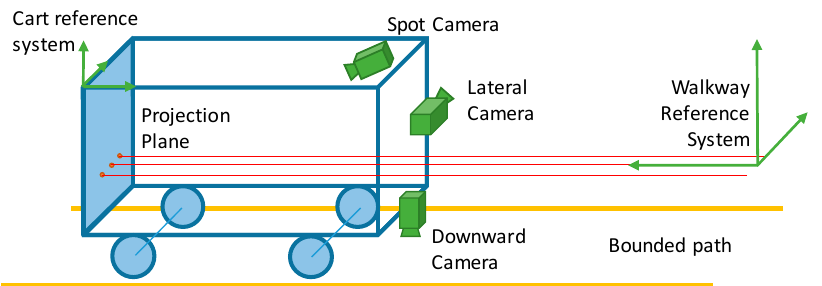
Figure 1. Scheme of the measurement chain.